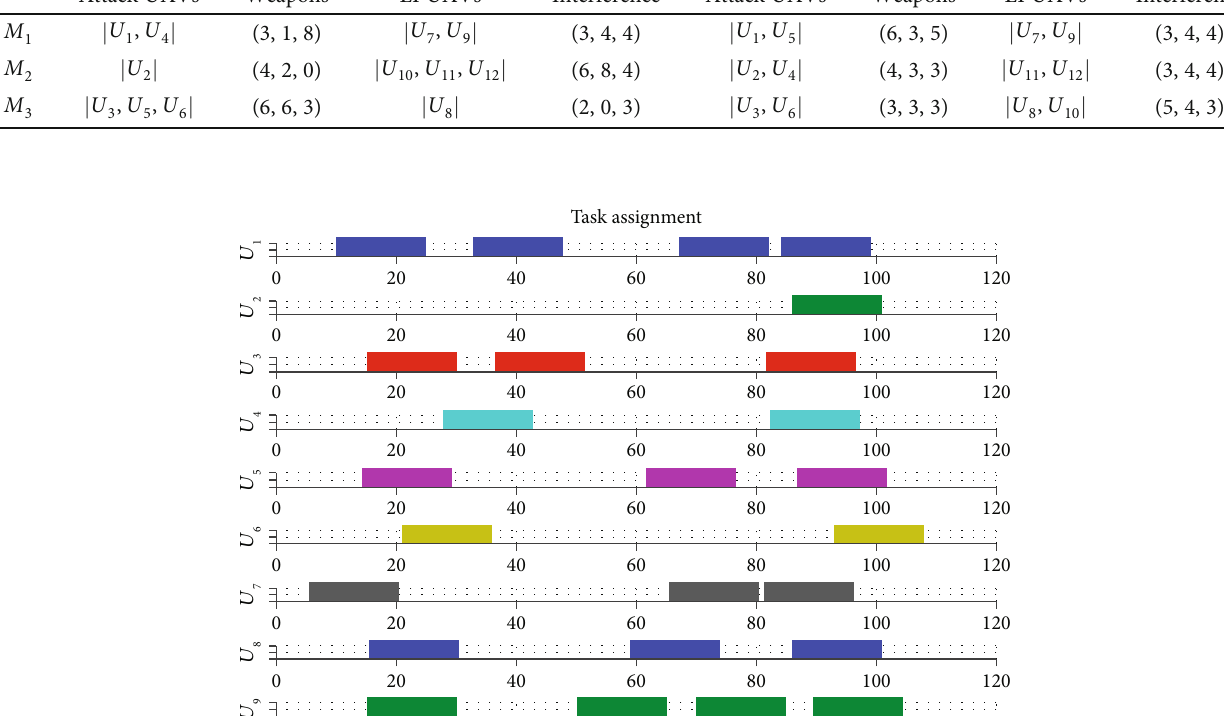
Table 6: The cluster member and task resource obtained by two kinds of clustering. M i